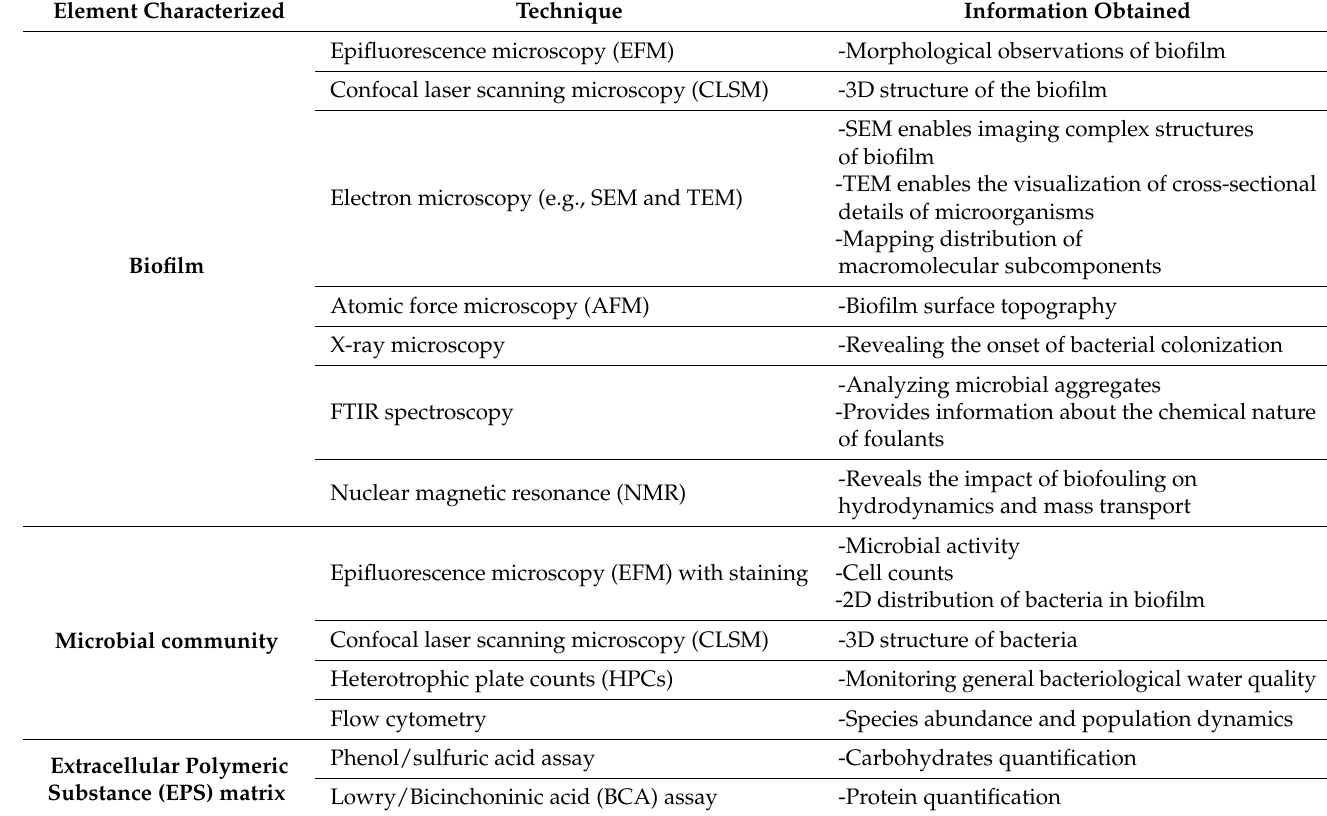
Table 1. Membrane biofouling characterization techniques